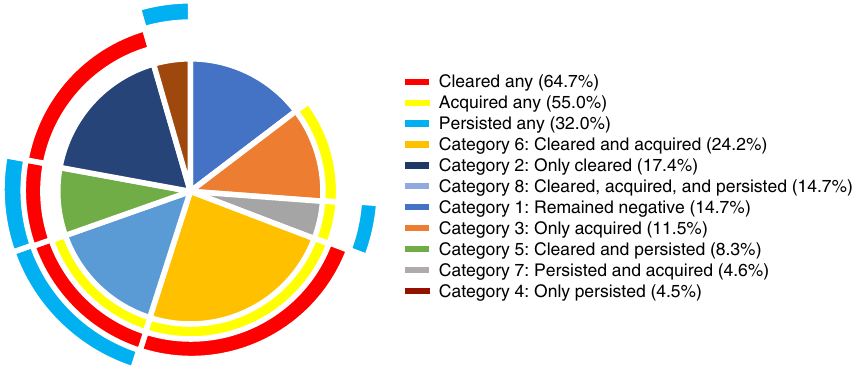
Fig. 2 The number of participants per HPV category in the CAPRISA 004 cohort ( N = 737). HPV outcomes were classi fi ed into three overlapping categories where any HPV type could have simultaneously been acquired (Acquired Any HPV), cleared (i.e. eliminated or kept latent; Cleared Any HPV), or persisted (Persisted Any HPV). Additionally, eight mutually exclusive categories were de fi ned: [Category 1] women who remained HPV negative ( n = 108), or converted [Category 2] from HPV positive to HPV negative status ( only cleared; n = 130) between visits, [Category 3] from HPV negative to HPV positive ( only acquired; n = 85), or [Category 4] only retained the same HPV types between visits ( only persisted; n = 33); or women who had a more mixed natural history whereby they [Category 5] cleared some HPV types while others persisted ( n = 61), [Category 6] cleared some and acquired new types ( n = 178), [Category 7] acquired some and some persisted ( n = 34), or [Category 8] cleared some, acquired some, and some persisted ( n = 108). Percentages re fl ect the frequency of observations among overlapping de fi nitions ( N = 737), and mutually exclusive de fi nitions ( N = 737)